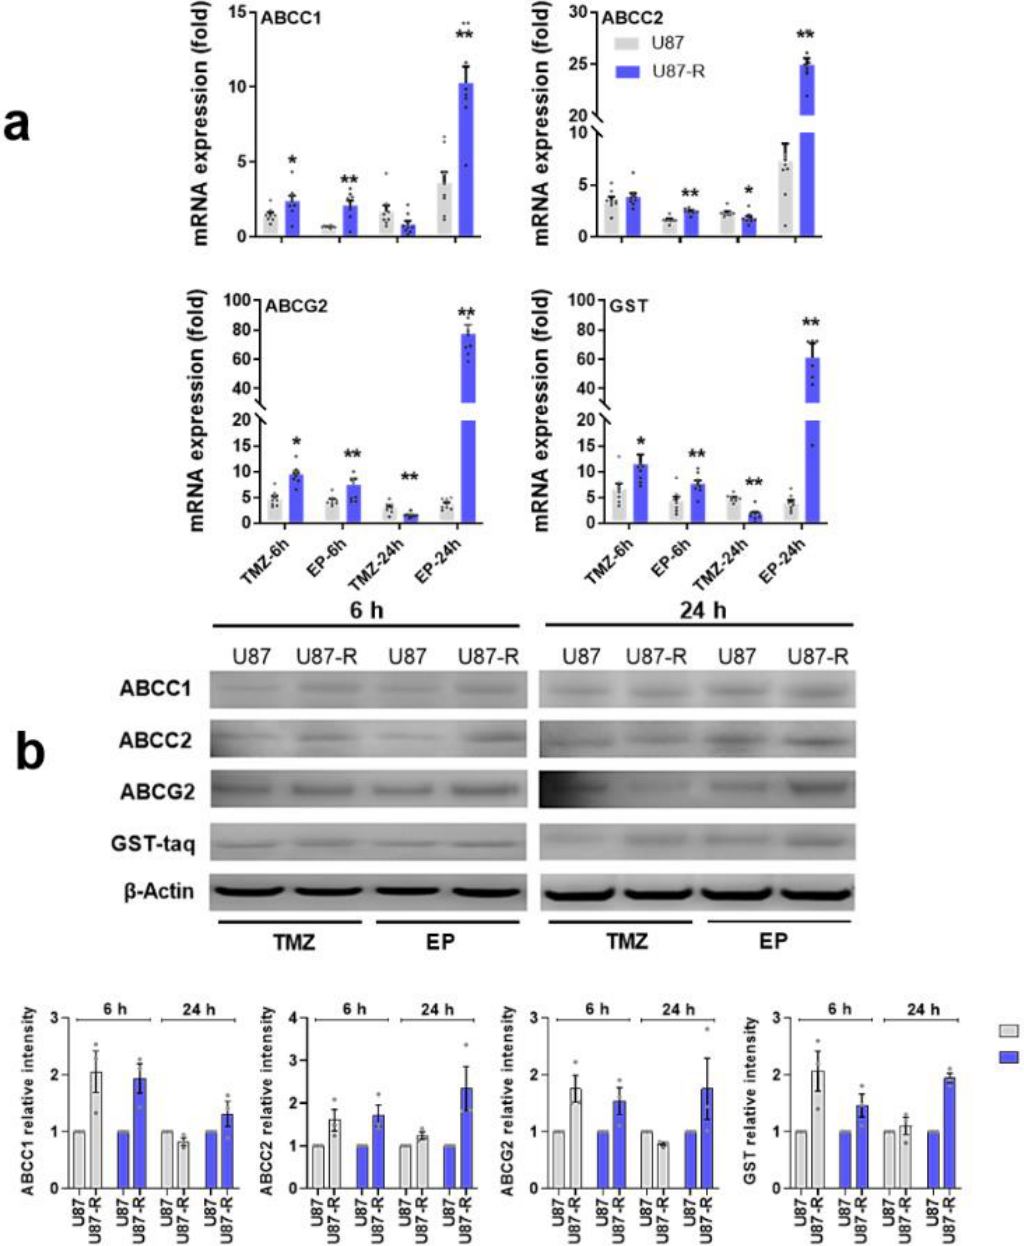
Figure 4: a) Relative fold change of ABCC1 , ABCC2 , ABCG2 , and GST in temozolomide (TMZ)- and etoposide (EP)-treated resistant U87-R and non-resistant U87 cells as determined by quantitative real- time PCR. All data were normalized to β-actin and GAPDH are given relative to control (control=1, not shown in figure). Data are represented as mean ± SE, n=8. *indicates significantly different values in U87-R vs U87 groups, Mann-Whitney U test: * p ≤0.05; ** p ≤0.01. b) Western blot analysis of ABCC1, ABCC2, ABCG2, and GST proteins (relative density normalized to β-actin). Data are represented as mean ± SE, n=3. Control: vehicle-treated control; TMZ: temozolomide, IC IC : 6.49 50